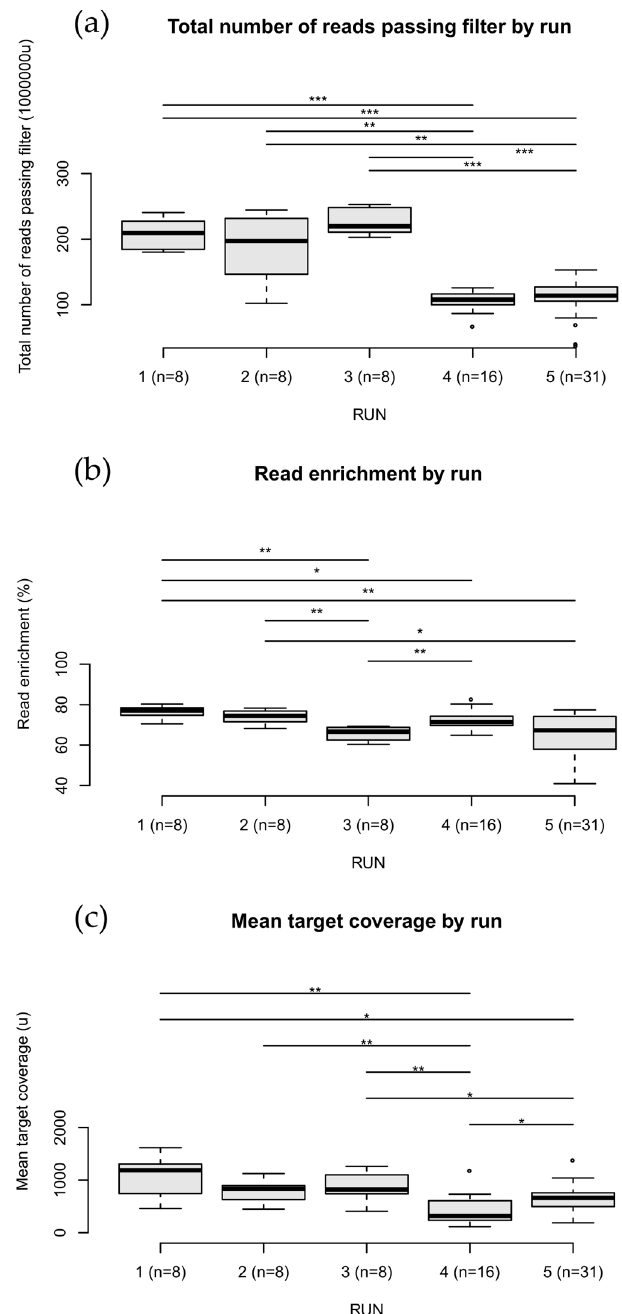
Figure 2. DNA sequencing quality metrics over 71 samples. Each boxplot shows the metrics distribution for the five runs. Pairwise comparisons between runs were done through a two-sided Wilcoxon rank-sum test ( p -value: *** p < 0.001, ** p < 0.01 and * p < 0.05). ( a ) Total number of reads passing (quality score > 30). ( b ) Read enrichment as the percentage of reads aligned on target over the total aligned ones. ( c ) Mean read coverage on the panel target probes.